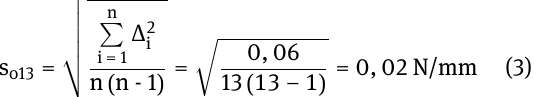
From measurement #1 of the spring 7 constant, see Ta- ble 1, was determined spring constant, k p = 18.42 ± 0.18 N/mm (interval 18.24 N/mm; 18.60